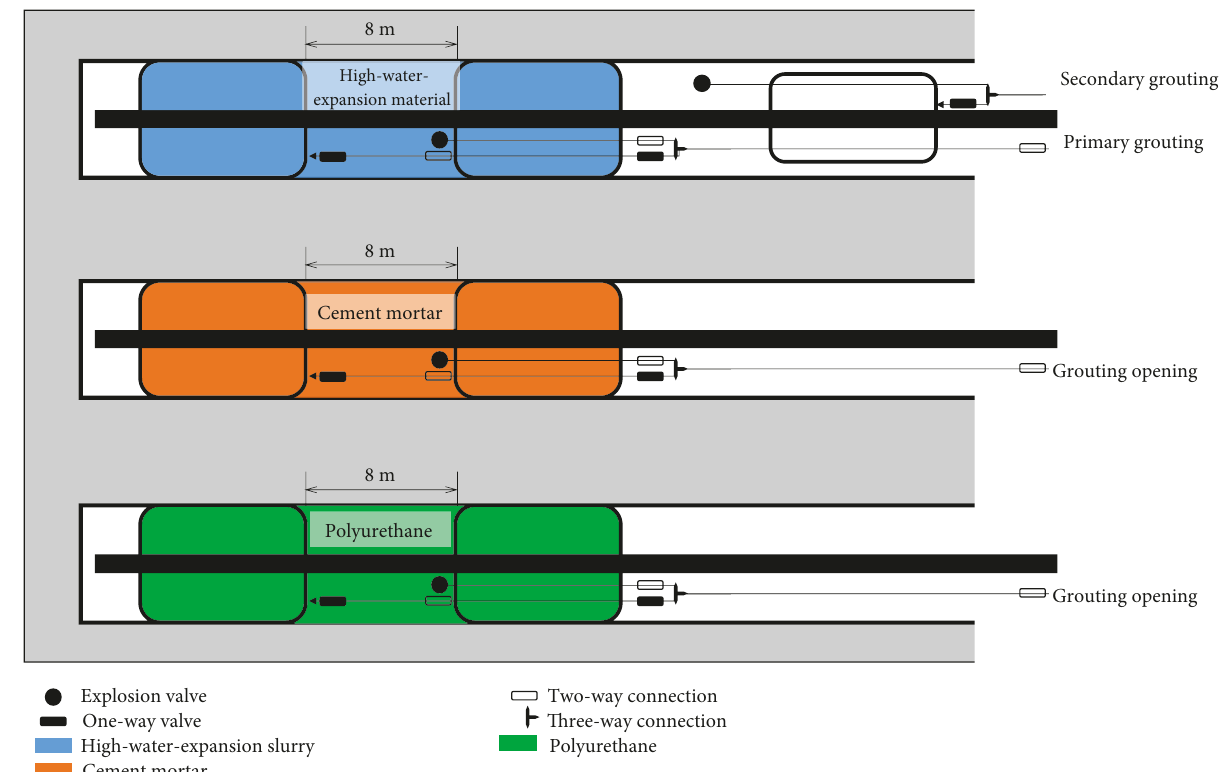
Figure 10: Comparative test scheme for di ff erent borehole-sealing materials and